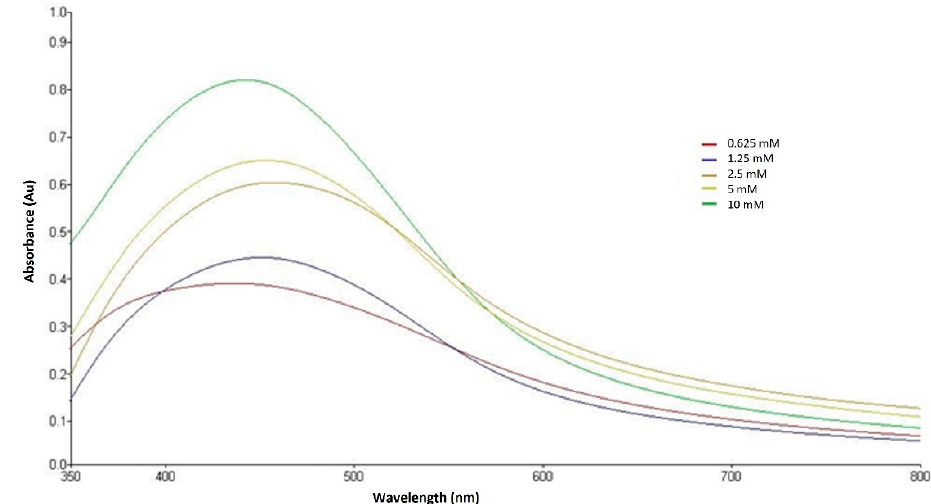
Figure 2. UV-Vis spectrum of solutions with green-synthetized silver nanoparticles.